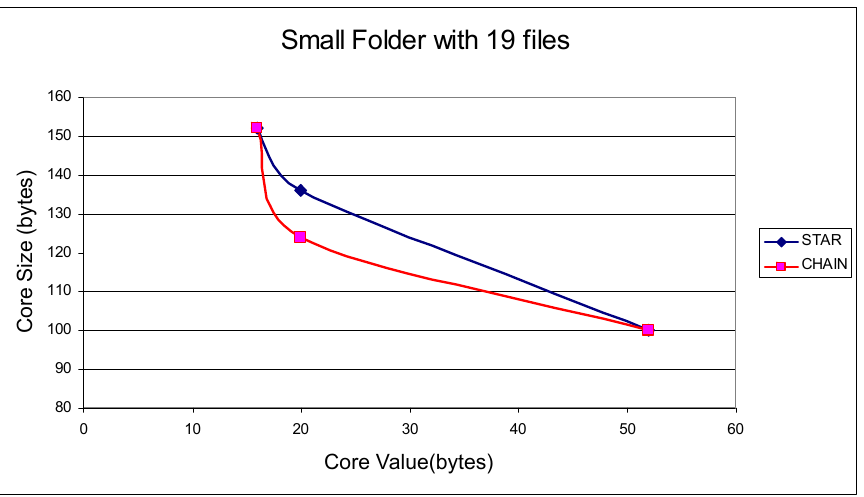
Figure 7. The k-cores and their (deduplicated) size for the set of 19 files in Table 1 using CHAIN and STAR topology. There are three k-cores for each connection topology: the top core (value “52”) with (deduplicated) size of 100 bytes, the middle core (value “20”) with size of 124 bytes for CHAIN connectivity and 136 bytes for STAR, and the lower core (value “16”) with size 152 for both connection